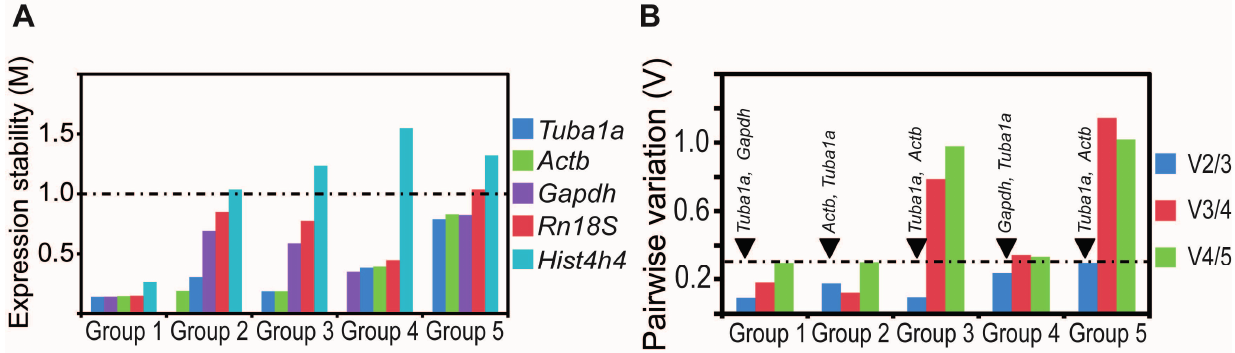
Figure 5. Calculation of average expression stability and pairwise variation coefficient for each of the putative reference genes. ( A ) Gene expression stability values ( M ) of the putative reference genes were calculated for each of the five experimental groups using the geNorm statistical algorithm. A lower M value indicated more stable gene